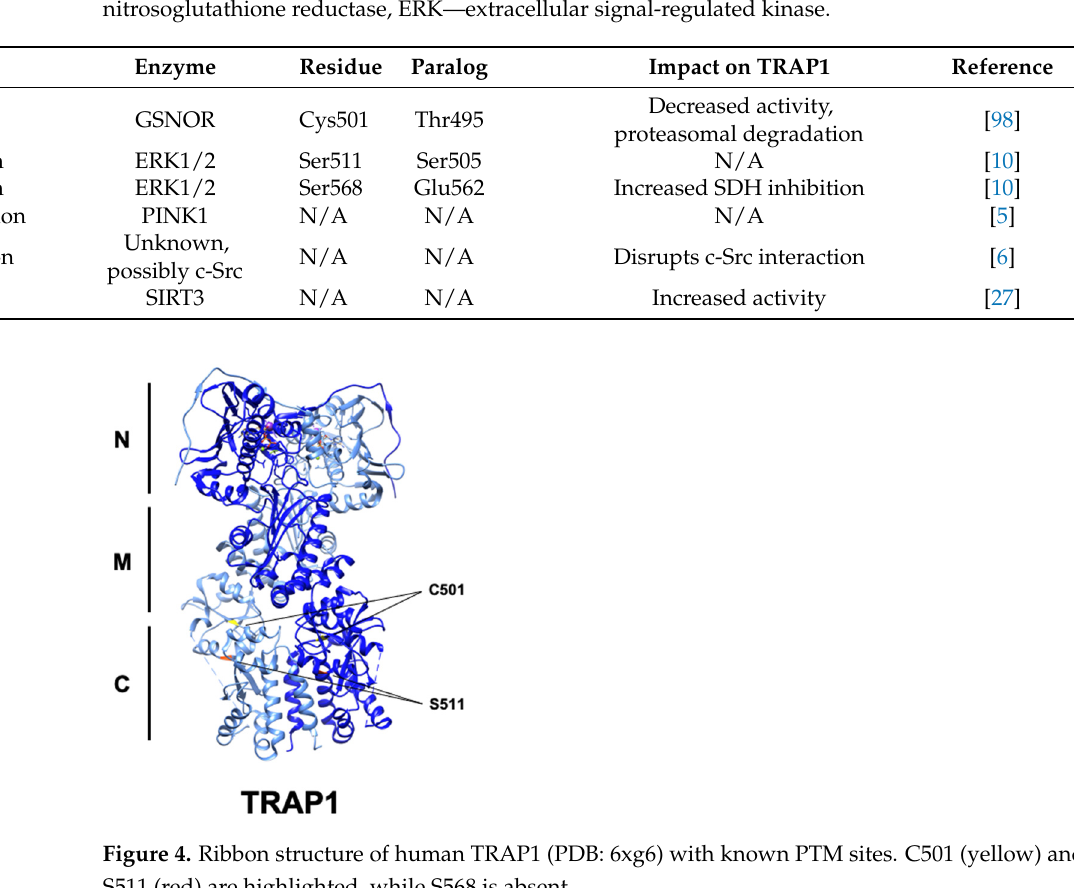
Table 1. Reported PTMs of TRAP1. Paralog identifies conserved residues in Hsp90 α . GSNOR—S-